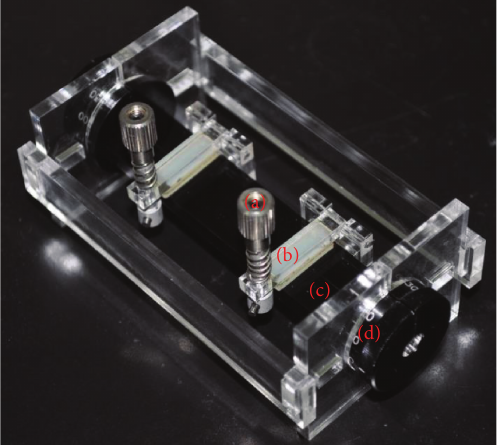
Figure 4: Fixture for the image-measuring instrument: (a) spring struts, (b) silicone gasket, (c) detection platform, and (d) scale turntable.